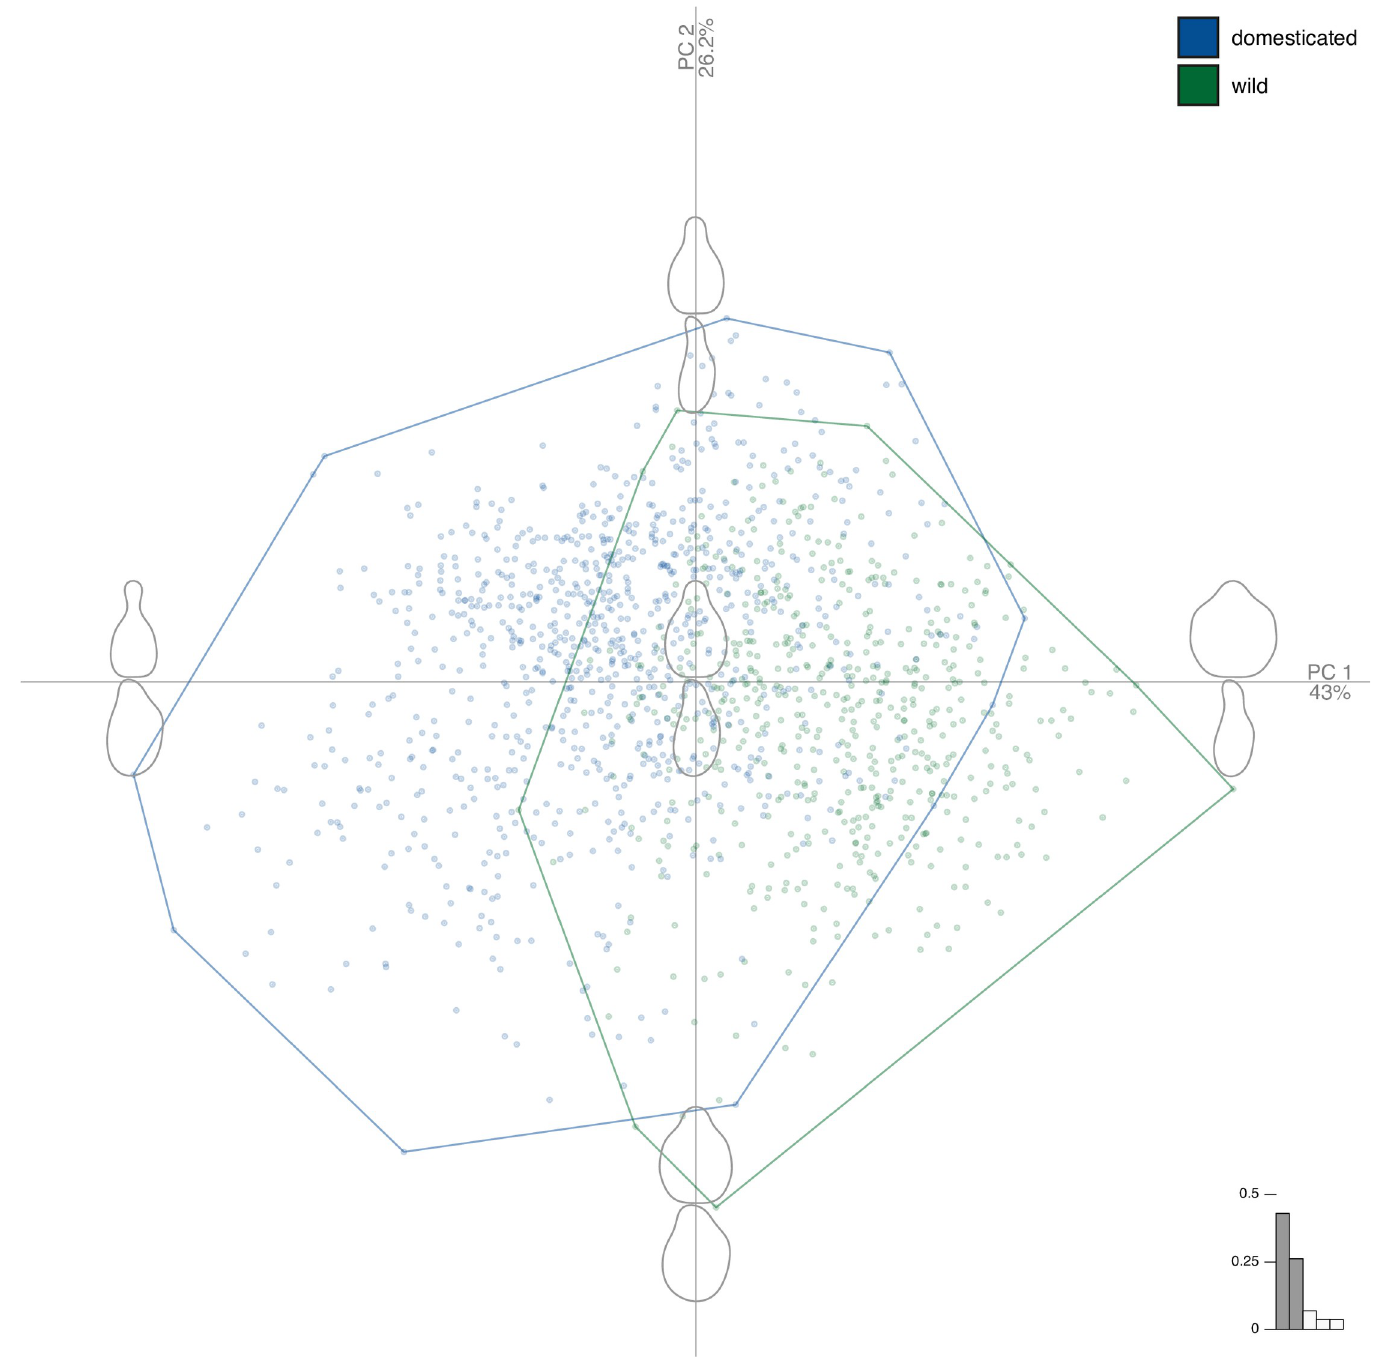
Fig 3. Principal component analysis on the joint matrices of Fourier coefficients obtained for the two views. The first two principal component gathered 69% of the total variance. The component of shape variation they capture are illustrated with reconstructed shapes at each extreme of their range. Colour of markers and convex hulls indicate pips from wild (green) and domesticated (blue)